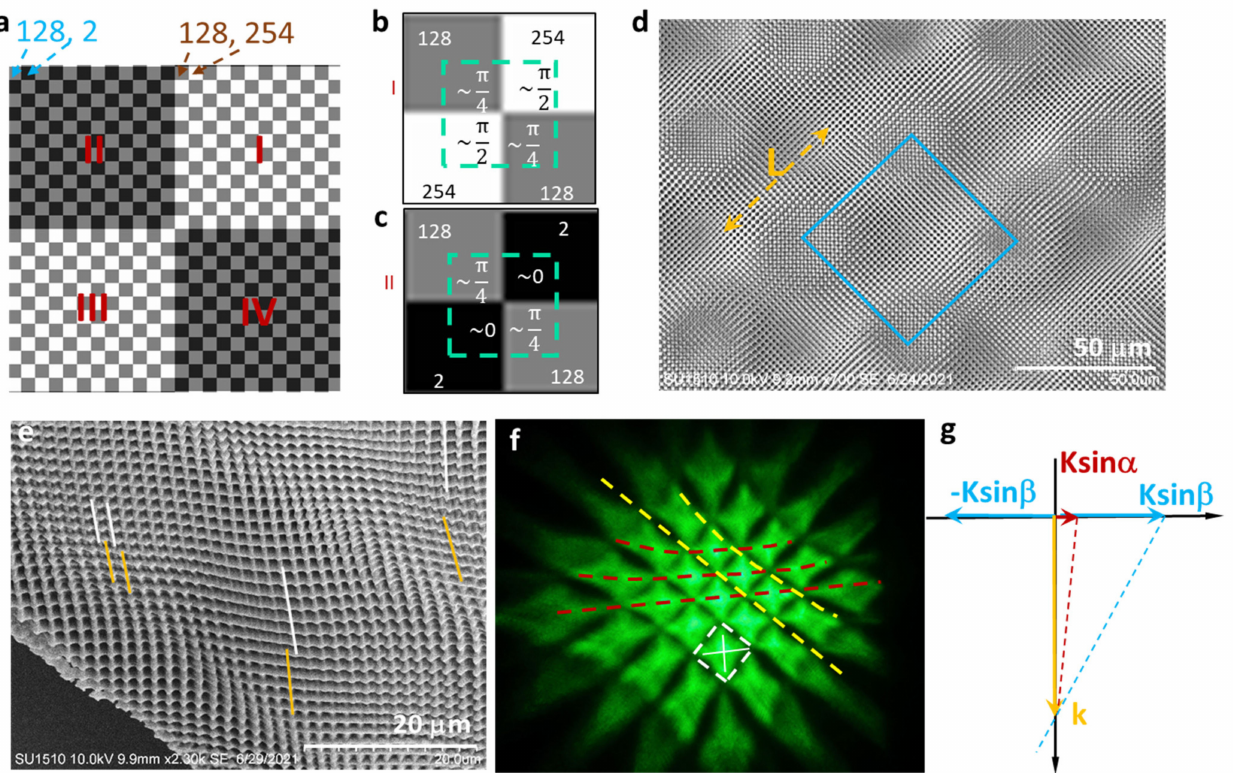
Figure 3. ( a ) Unit super-cell of type-2 phase pattern with gray levels of (128, 254) in checkerboard format in quadrant I and (128, 2) in quadrant II. ( b , c ) Enlarged view of checkerboard unit-cell in quadrant I and II, respectively. The phases of diffracted beams are labeled individually. ( d ) SEM image of type-2 3D GPSC with the solid blue square indicating a unit cell and the dashed yellow line showing the long period of dual-period GPSC, and ( e ) its SEM image of bottom surface with the dual lattice feature indicated by the white and yellow lines. ( f ) 5 × 5 Diffraction zones from type-2 3D GPSC. The dashed white square indicates one diffraction zone. ( g ) The wave vectors for outer beam (blue arrow), inner beam (red arrow), and central beam (yellow arrow). The dashed red line is slightly tilted from the vertical